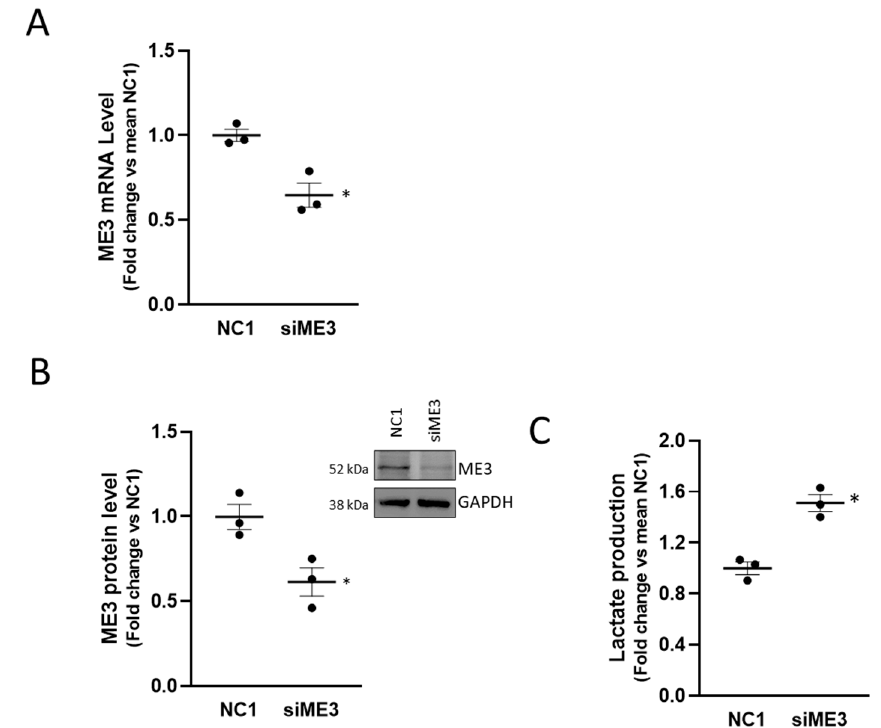
Figure 7. Effect of ME3 silencing on lactate production: ( A ) qPCR determination of ME3 mRNA level after 48 h of ME3 silencing (siME3) compared to control (NC1). ( B ) Representative western blot of ME3 after 48 h of ME3 silencing in PC3 cells (right panel); densitometric analysis of ME3, GAPDH was used as a loading control. Uncropped Western Blots of Figure 7B are available in Figure S14. ( C ) Lactate concentration analysis by colorimetric assay in PC3 cells after ME3 silencing collected at 48 h after transfection. Results are plotted as fold change vs. mean NC1. Individual values ( n = 3) with mean ± SEM are shown. Non-parametric paired two-tailed Student’s t -test determined statistical significance. * p ≤ 0.05 MALAT1gapmer vs.